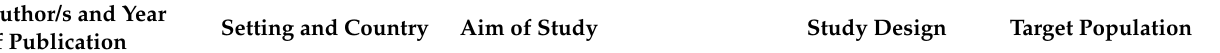
Table 1. Characteristics of included studies ( n =